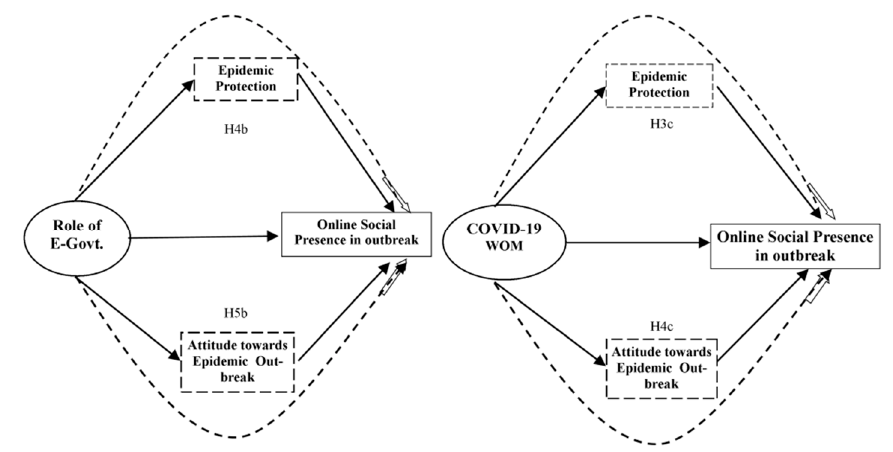
Figure 2. Multi-mediation model.